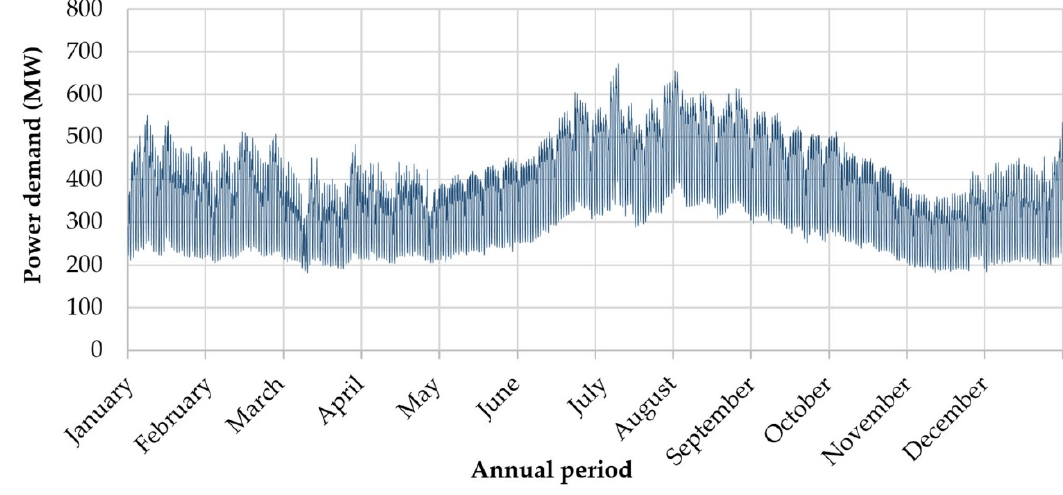
Figure 7. Annual electricity demand fluctuation for the year 2019 as per hours [50].